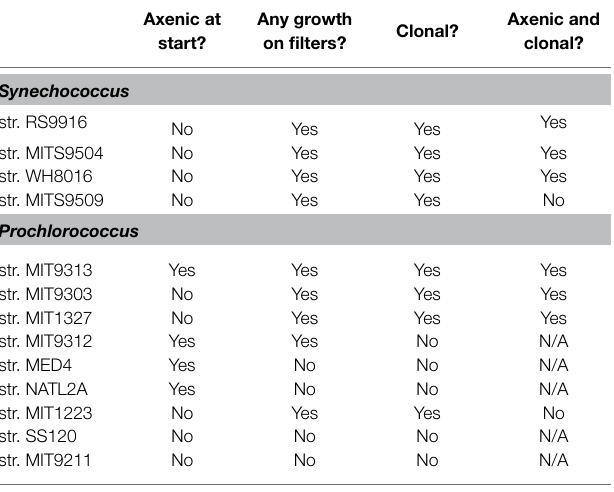
TABLE 1 | Recovery, clonality, and axenicity of clones of Synechococcus and Prochlorococcus following filter plating with Henriciella pelagia str. MIT2000, except for Prochlorococcus str. MIT1327, which was recovered with Alteromonas macleodii str. MIT1002. Axenic at Any growth Axenic and Clonal? start? on filters? clonal?